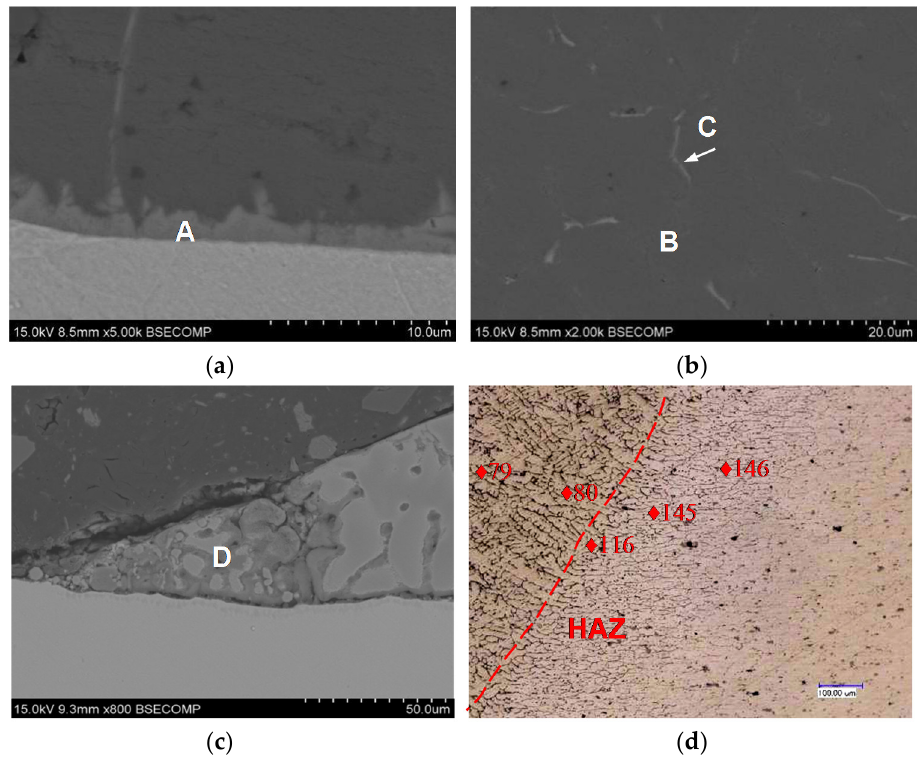
Figure 8. Microstructures of bead-on-plate brazing (without preheating): ( a ) interfacial layer; ( b ) weld metal zone; ( c ) Zn-rich zone; ( d ) heat affected zone (HAZ) zone. Table 3. Energy dispersive spectrometer (EDS) energy spectrum analysis. Location